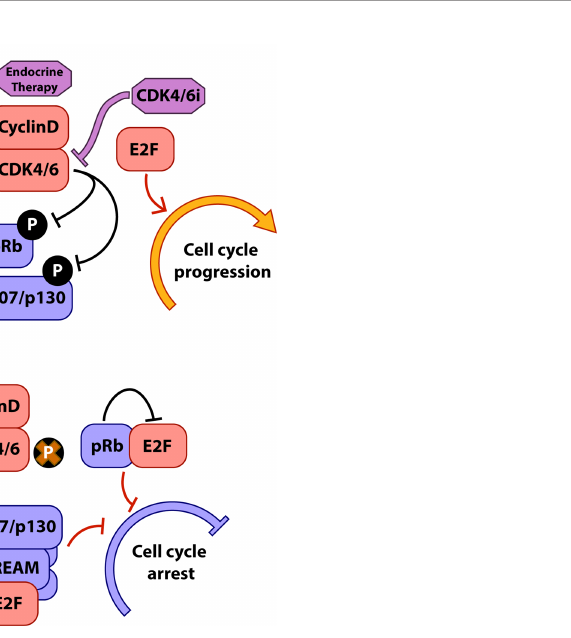
FIGURE 1 | Key interactions of MDM2 during hormone-stimulated proliferation and p53 activation. Protein interactions are indicated with black arrows, transcriptional interactions with red arrows, and the activity of therapeutic interventions with purple arrows. P, phosphorylation, Ac, Acetylation, Ub,